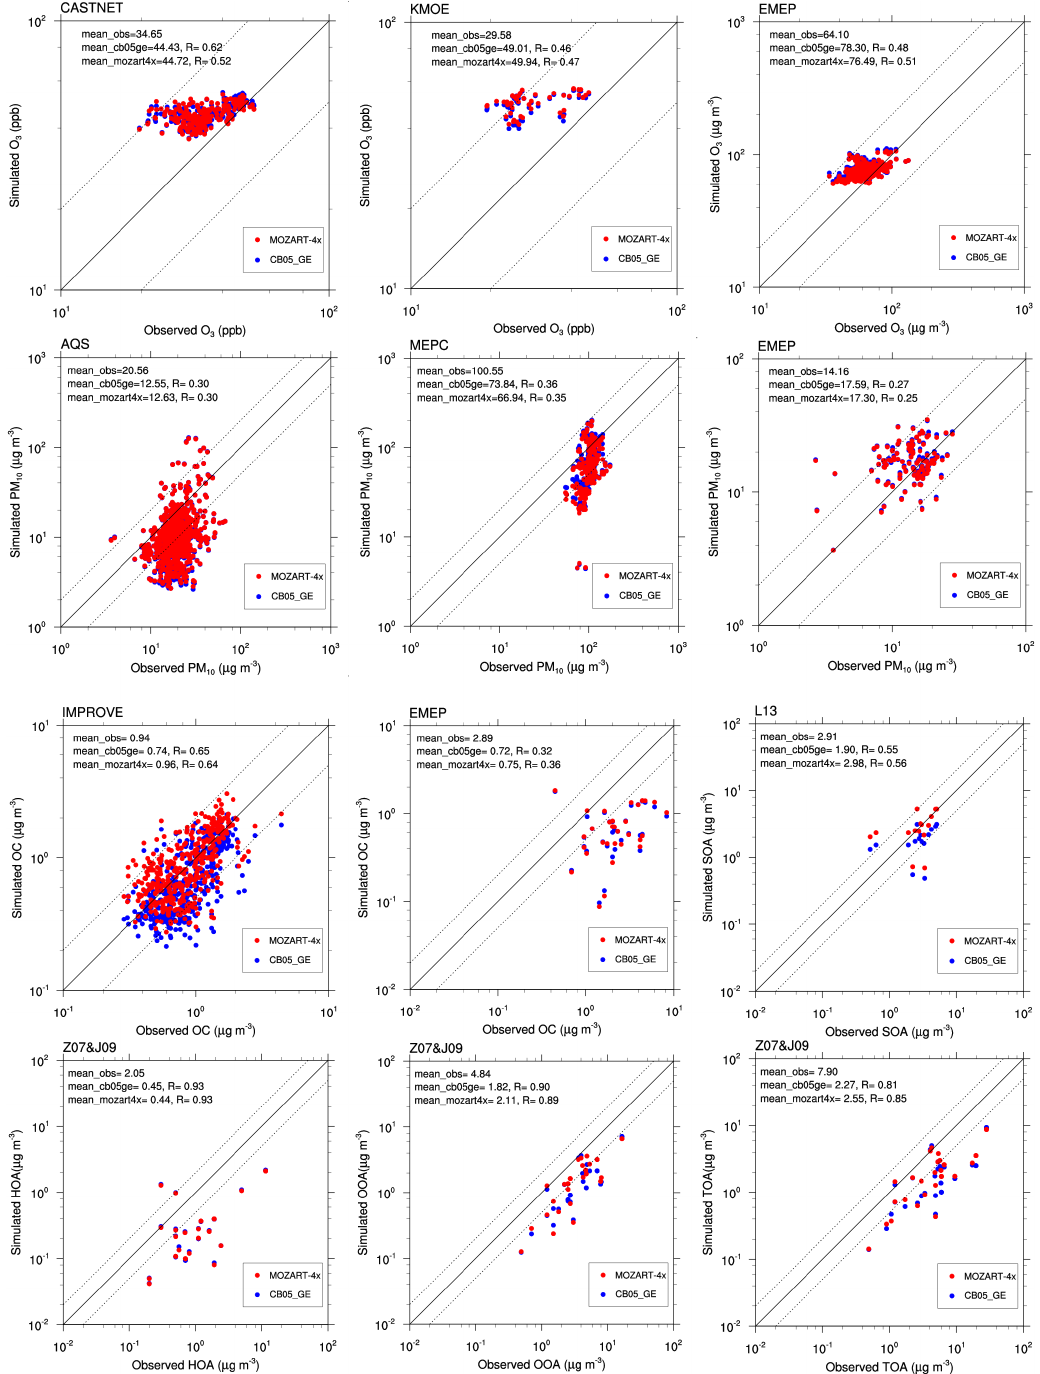
Figure 1. Scatterplots of O 3 , PM, organic carbon (OC), secondary organic aerosol (SOA), hydrocarbon-like organic aerosol (HOA), oxy- genated organic aerosol (OOA), and total organic aerosol (TOA) over various sites during 2008–2010.